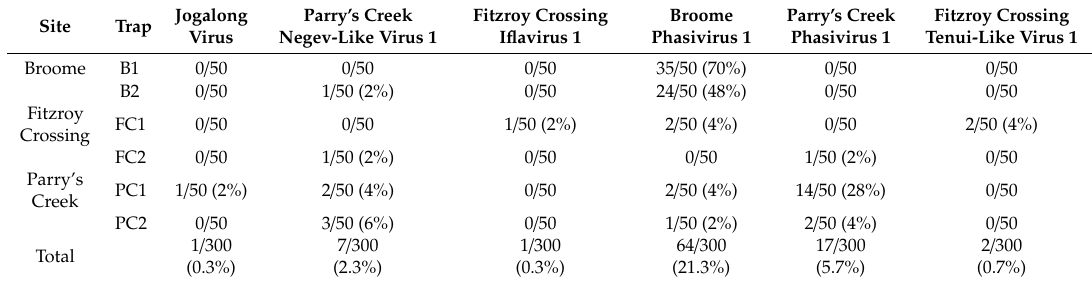
Table 4. PCR screening of individual Culex annulirostris mosquitoes for viruses identified by HTS of pooled